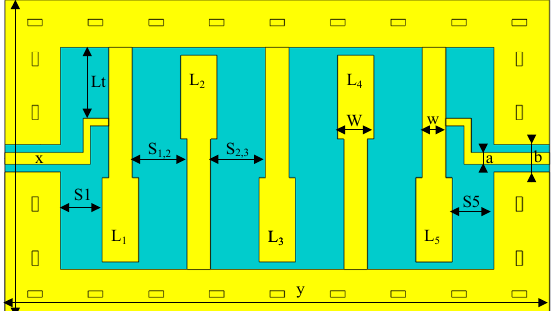
Figure 4. Two-dimensional structure of the fifth-order interdigital filter.